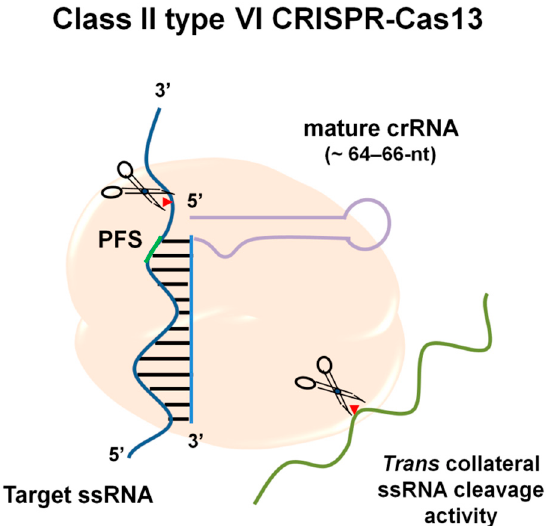
Figure 1. Mechanism of action of CRISPR-Cas13. The simplicity of the CRISPR-Cas13 system comprises two components: the programmable single-effector RNA-guided RNase Cas13 and a 64–66 nt CRISPR RNA (crRNA), best known as guide RNA, which recognizes the target RNA through the PFS (green), analogous to the protospacer adjacent motif, or PAM, a sequence recognized by Cas9. Scissors represent cis (on target) and trans cleavage (promiscuous cleavage), exerted by Cas13 through two HEPN domains, which together form the active ribonuclease site. This depiction represents the targeting or viral interference stage in the ‘adaptive’ immune system in bacteria and archaea, where foreign genetic elements or target ssRNA (e.g., the invading phage ssRNA) is cleaved by the crRNA–Cas13 complex. PFS: Protospacer-flanking site.